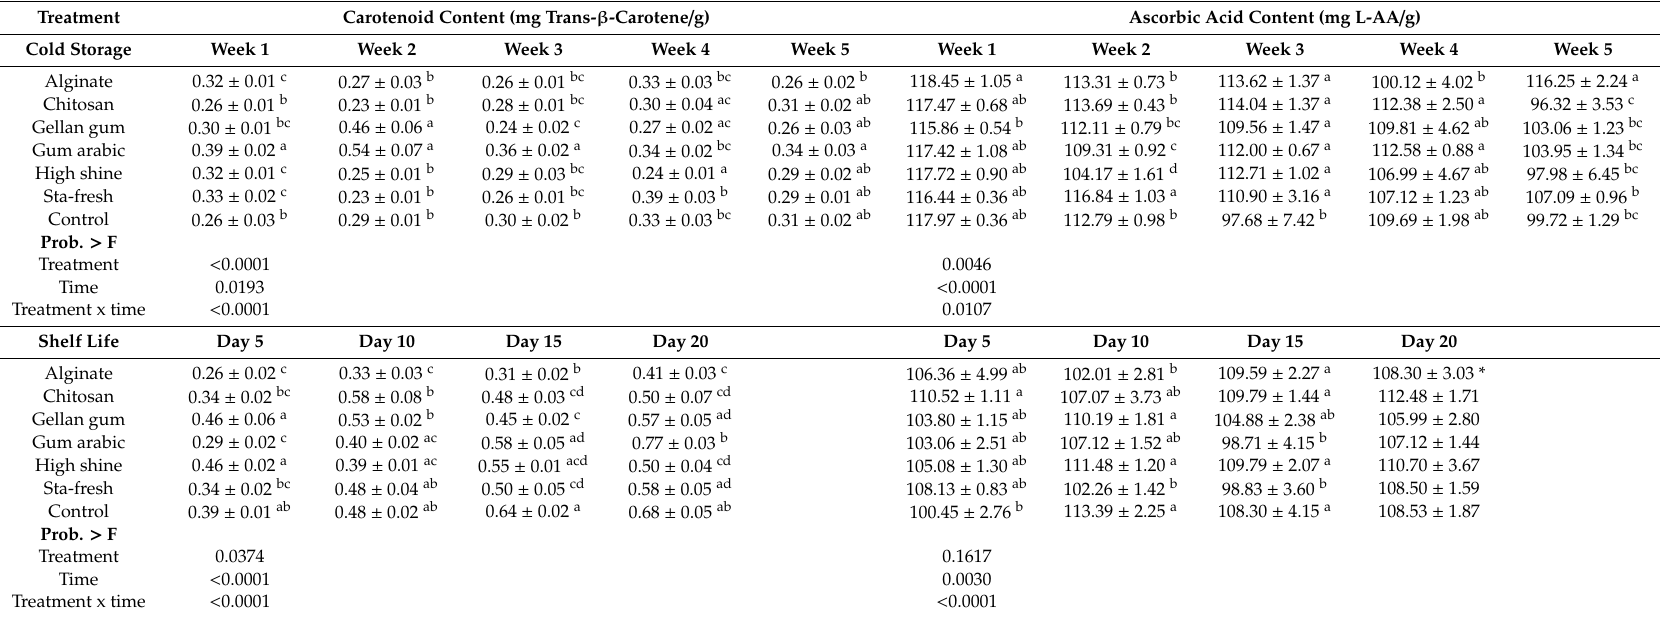
Table 5. Carotenoid content (mg trans- β -carotene / g) and Ascorbic acid content (mg L-AA / g) in plums (‘African Delight ™ ’) during a simulated shipping period (cold storage; − 0.5 ± 2 ◦ C and 90 ± 5% RH for 5 weeks) and shelf life (20 ± 2 ◦ C and 75 ± 5% RH for 20